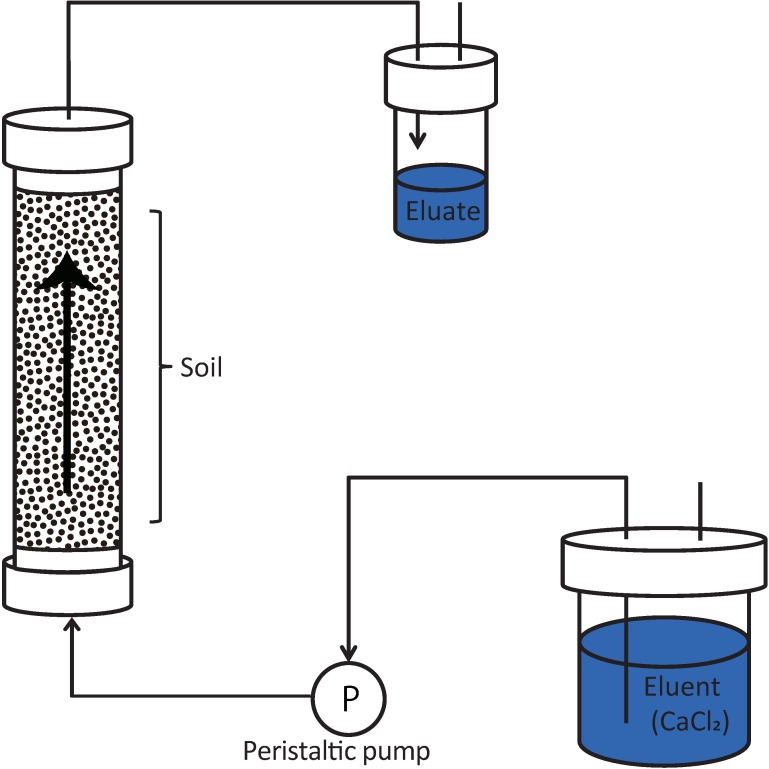
Diagram of the up-flow column percolation test (Modified from Naka et al., [16]).